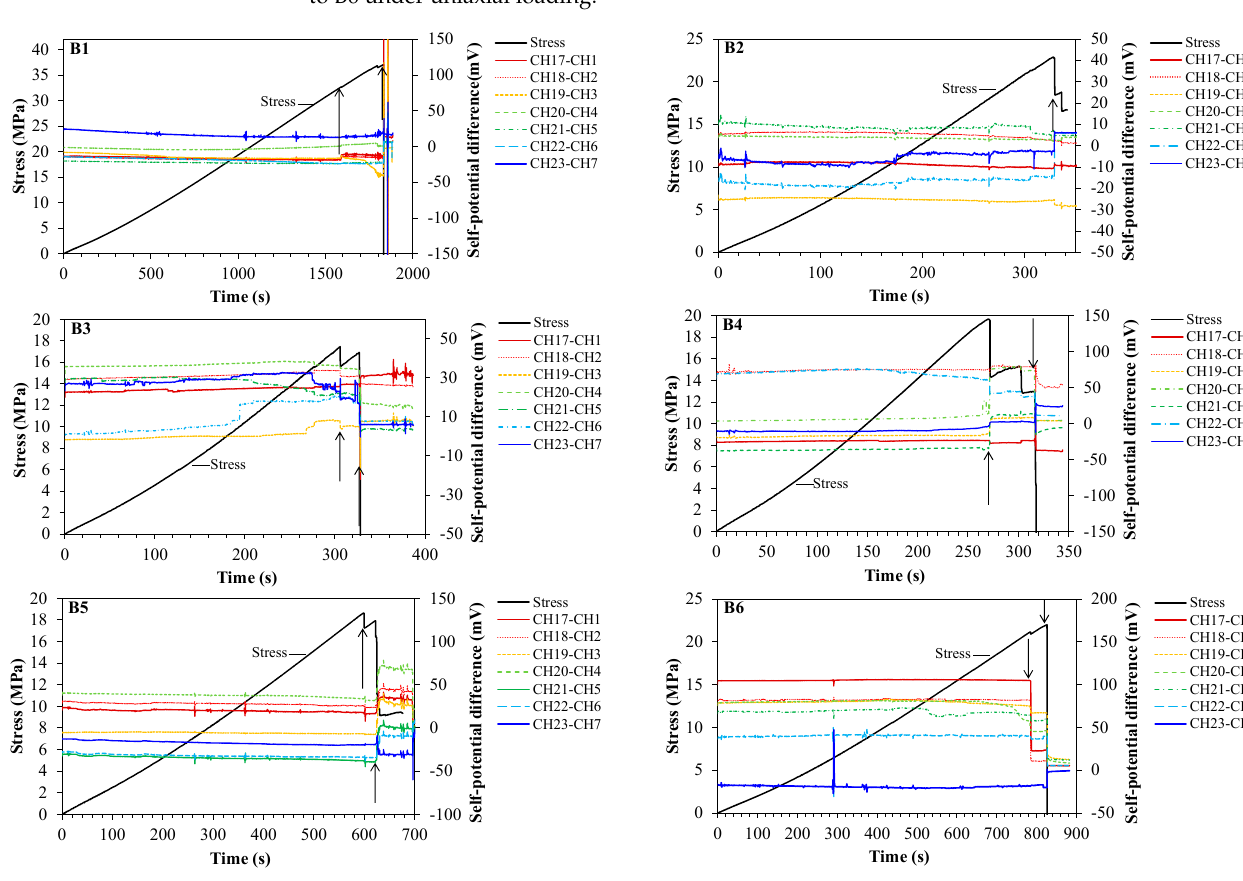
Figure 8. Curves of stress and radial self-potential difference with time of bituminous coal samples B1 to B6 under uniaxial loading.